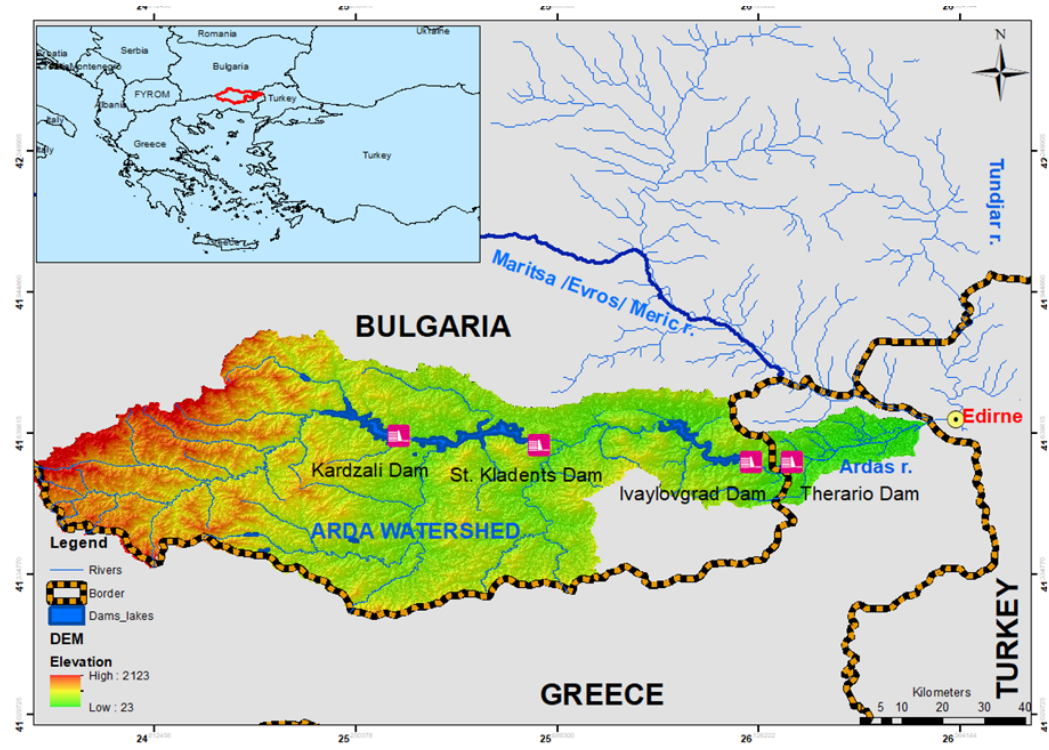
Figure 1. The Arda river catchment area that is sheared between Bulgaria and Greece. The downstream Greek part of the basin is most vulnerable to